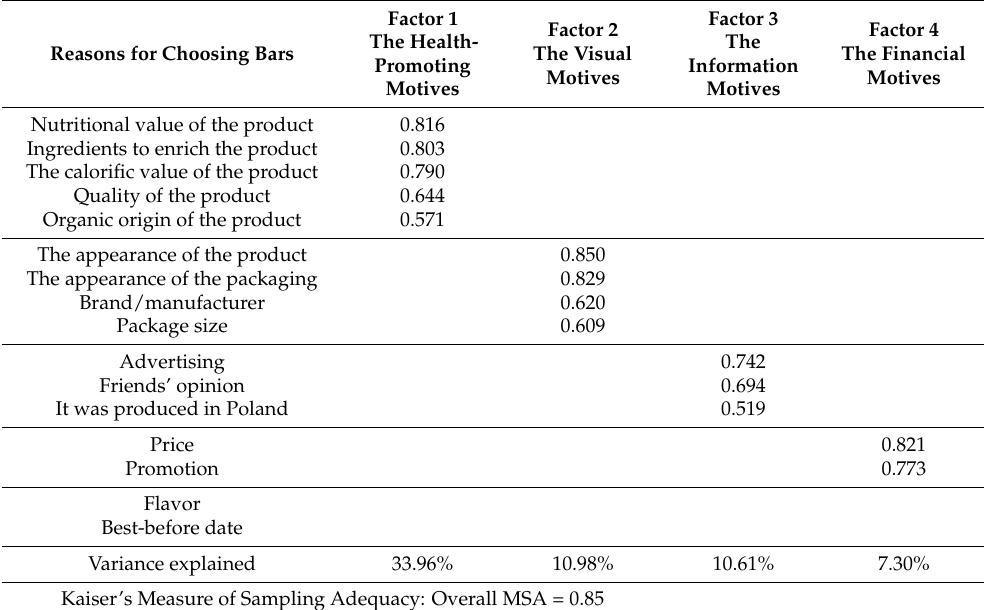
Table 2. Factor analysis of the choice motives regarding fruit and cereal bars; varimax rotated factor loadings; and percentage of explained variance ( n = 1034, Poland).